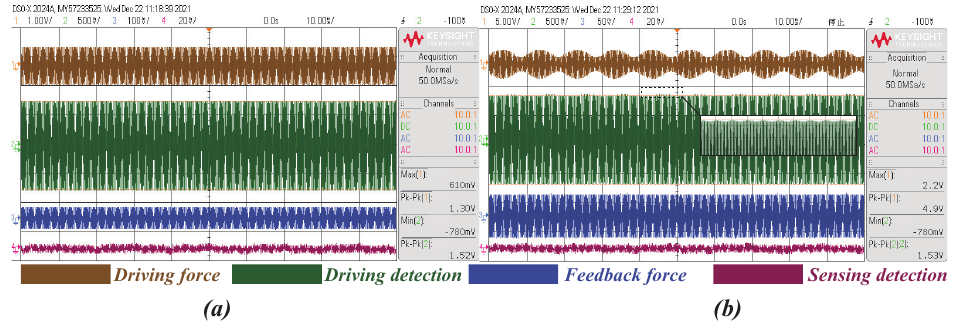
Figure 11. The oscillograms of the test signals. ( a ) No injecting reference signal. ( b ) With injecting reference